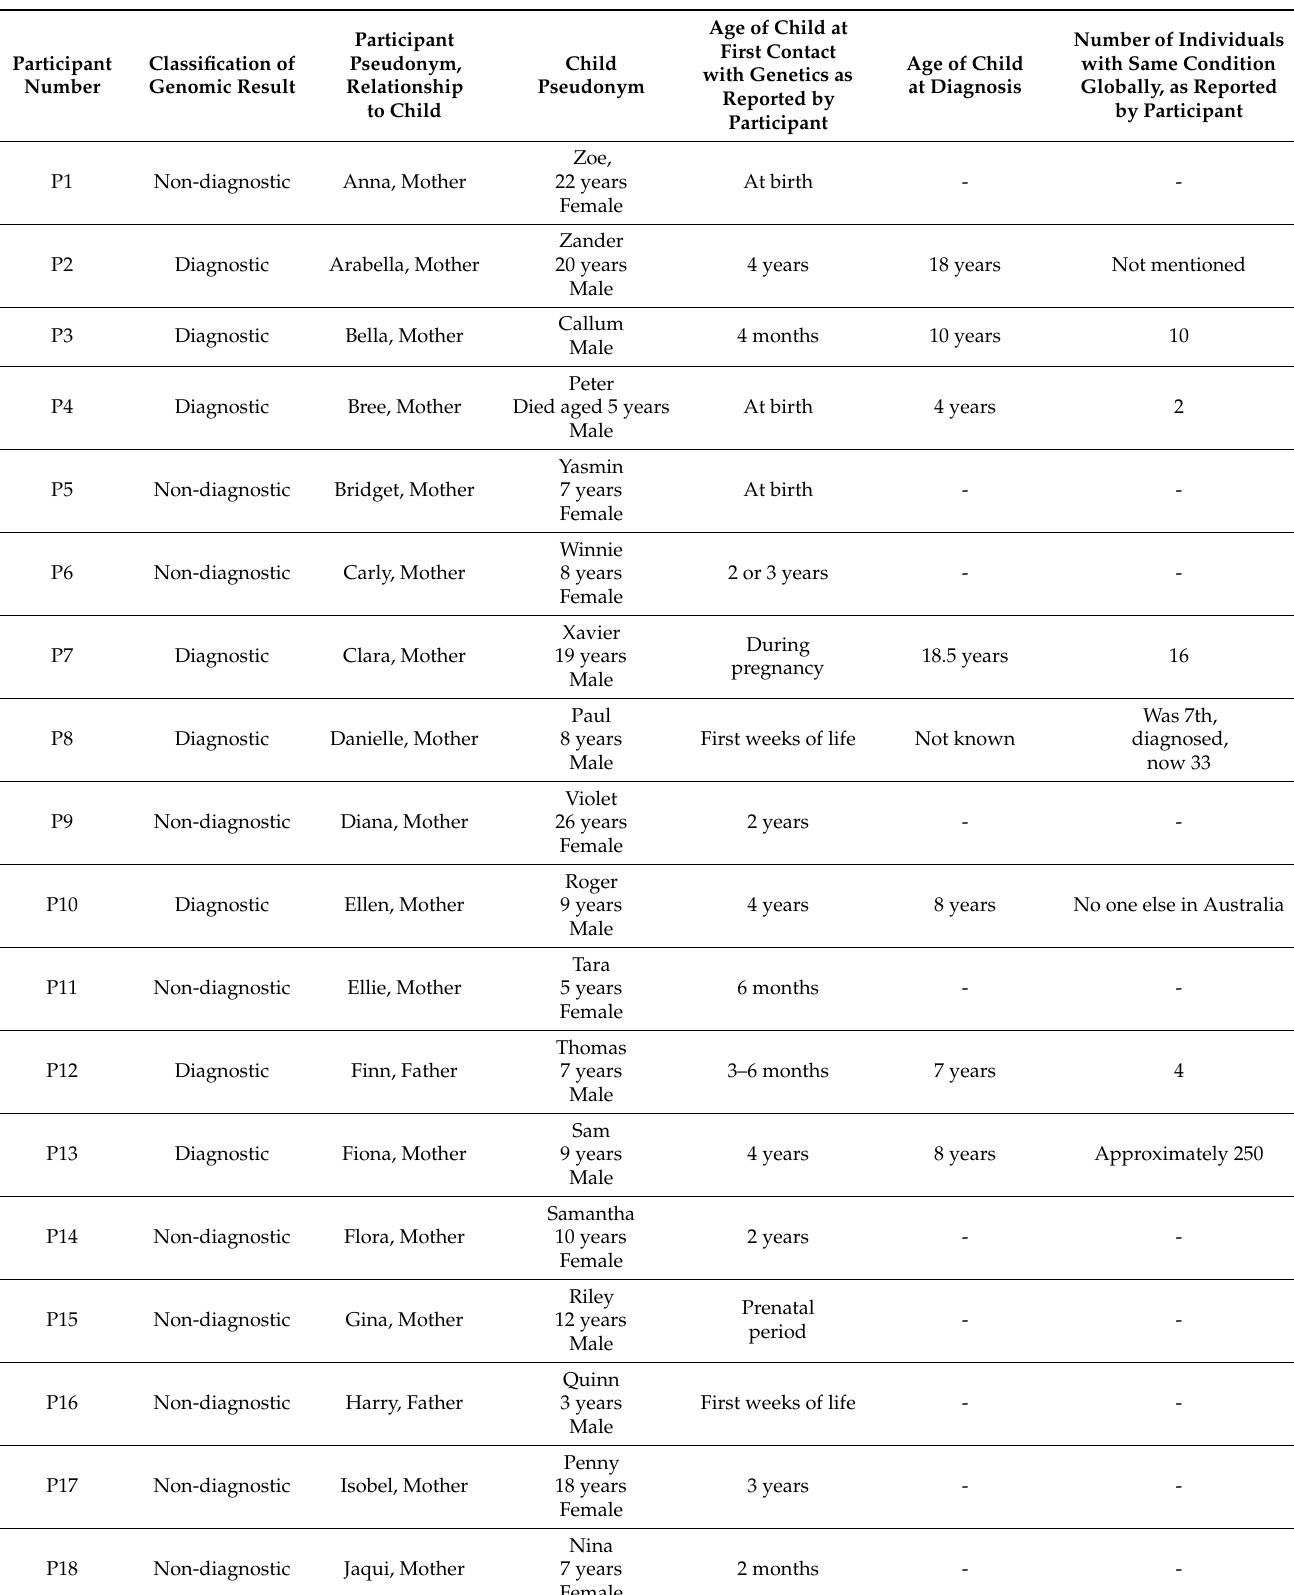
Table 2. Participant